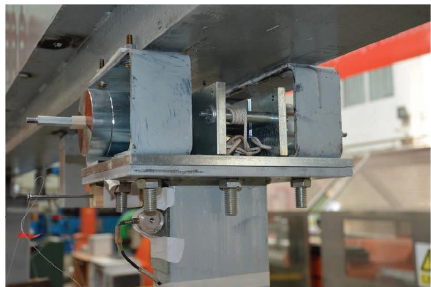
Figure 3: Connection of sliding bearing pier. Table 3: Additional weight